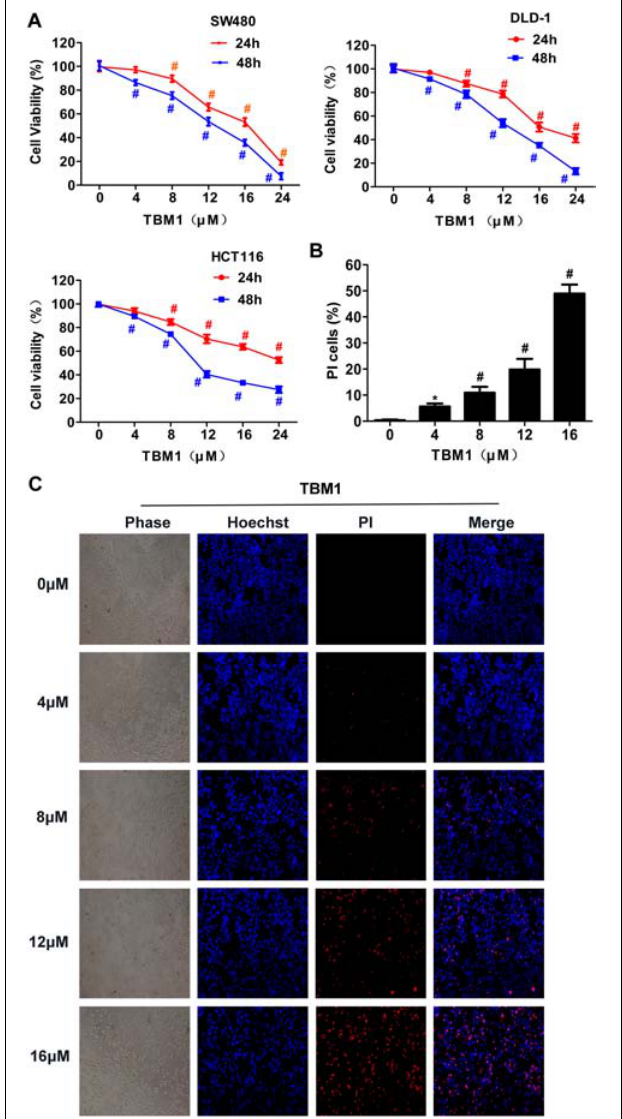
FIGURE 4 | TBM1 triggers necroptotic cell death in multiple CRC cells. (A) The CRC cell lines were treated with different concentrations of TBM1 for 24 or 48 h. Cell viability was measured by MTT assay ( n = 5). (B) After treatment with TBM1 for 48 h, SW480 cells were stained Hoechst and PI. PI positive cells were analyzed fluorescence microscope. (C) Fluorescent images were captured by fluorescence microscope (100 × ). Data presented were showed as means ± SD. ∗ p < 0.05, # p <